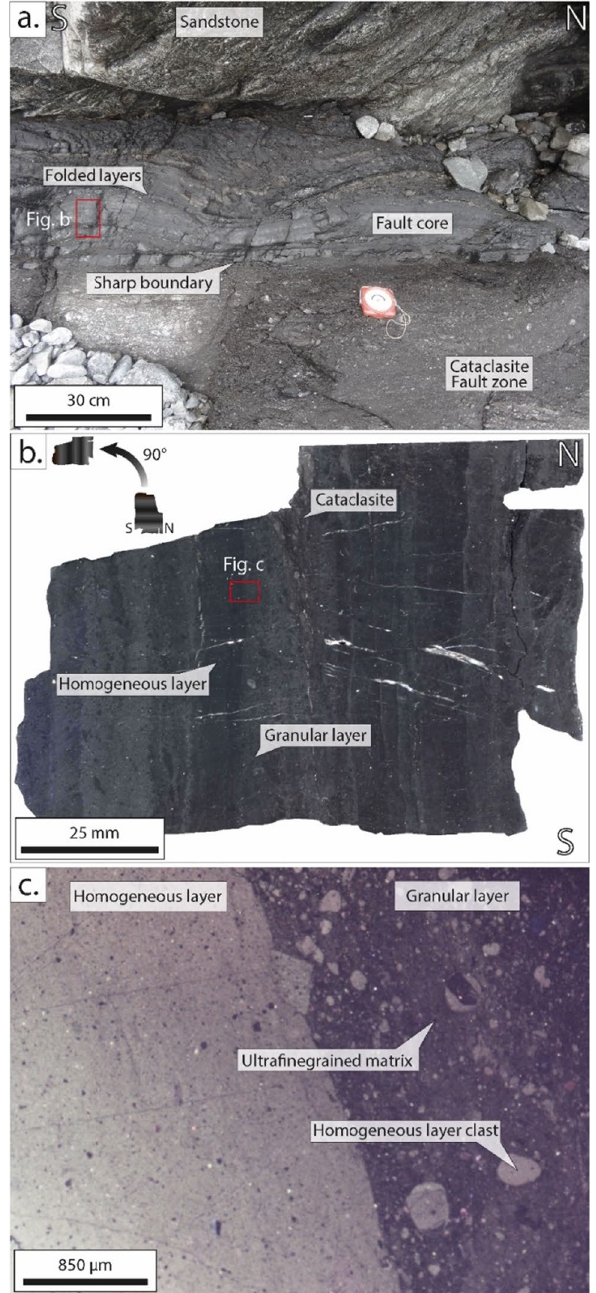
Figure 2. Structures and microstructures of a Black Fault Rock from Kodiak Island highlighting the multi- layering (Alaska, USA). ( a ) Outcrop in the Kodiak Accretionary Complex showing the aphiric fault core sharply cutting the host rock and folded in a later stage ( b ) Internal structure of Kodiak Black Fault Rocks showing alternations of homogeneous and granular layers ( c ) Cathodoluminescence image of Kodiak Black Fault Rock, highlighting the difference between the granular and the homogeneous layers and showing clasts of the homogeneous layer embedded in an ultrafine-grained